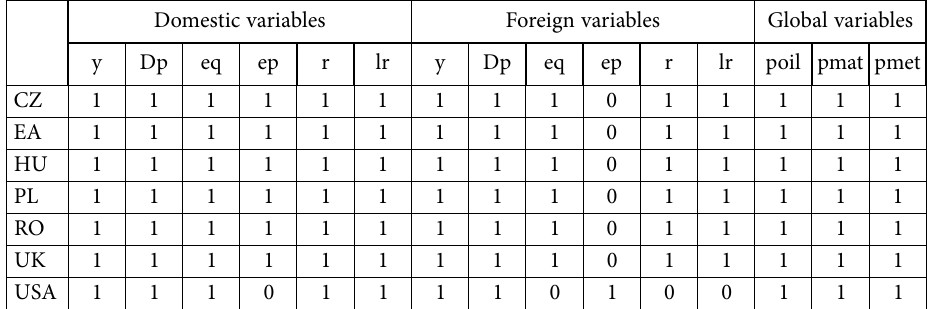
Table 1. Individual models specifications (source: authors’ calculations) Domestic variables Foreign variables Global